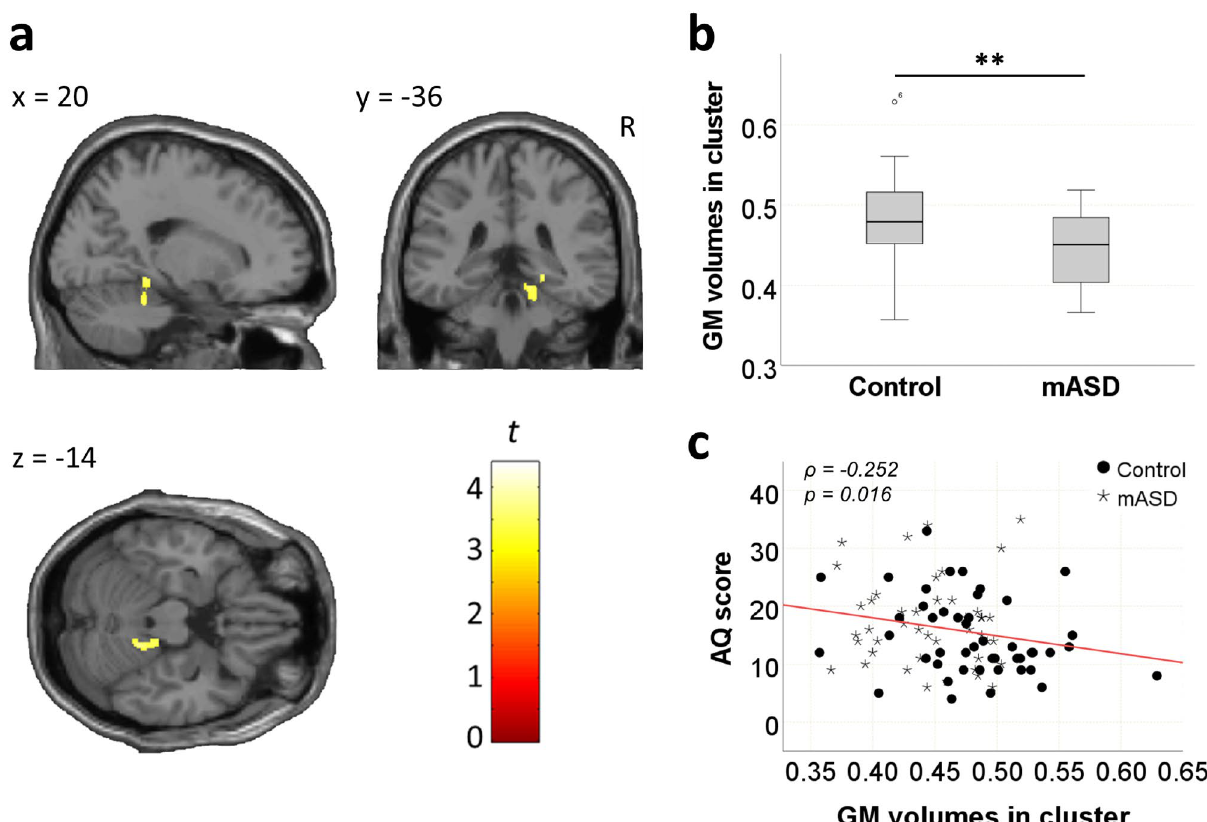
Figure 3. Grey matter volume differences between the mASD and control groups in the second cluster. ( a ) The second significant cluster was observed in the right cerebellum and parahippocampal gyrus. ( b ) Grey matter volume of the cluster was significantly different between the mASD and control groups ( t (89) = 3.528 , P = 0.001). ( c ) Scatter plot showing negative correlation between the grey matter extraction of the cluster and AQ scores for all subjects. The grey matter volume of the cluster was negatively correlated with AQ scores (ρ = − 0.252, P = 0.016). ** P < 0.01. GM grey matter, mASD mothers of individuals with autism spectrum disorder, AQ autism spectrum